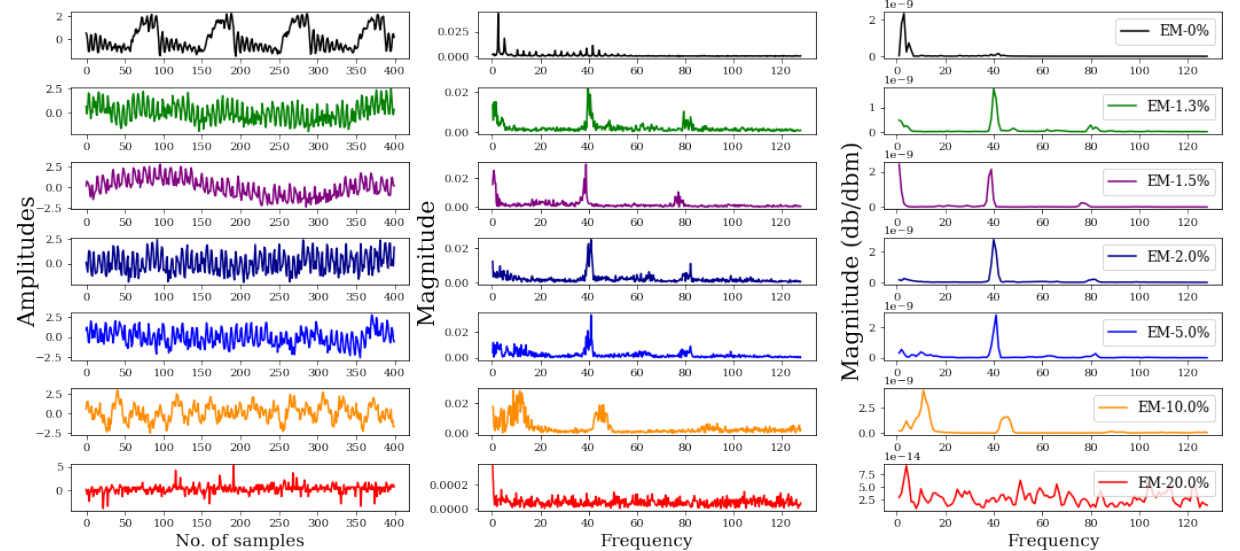
Figure A3. CR signals and their FFT and PSD outputs at 1500 RPM for the emulsion compositions.